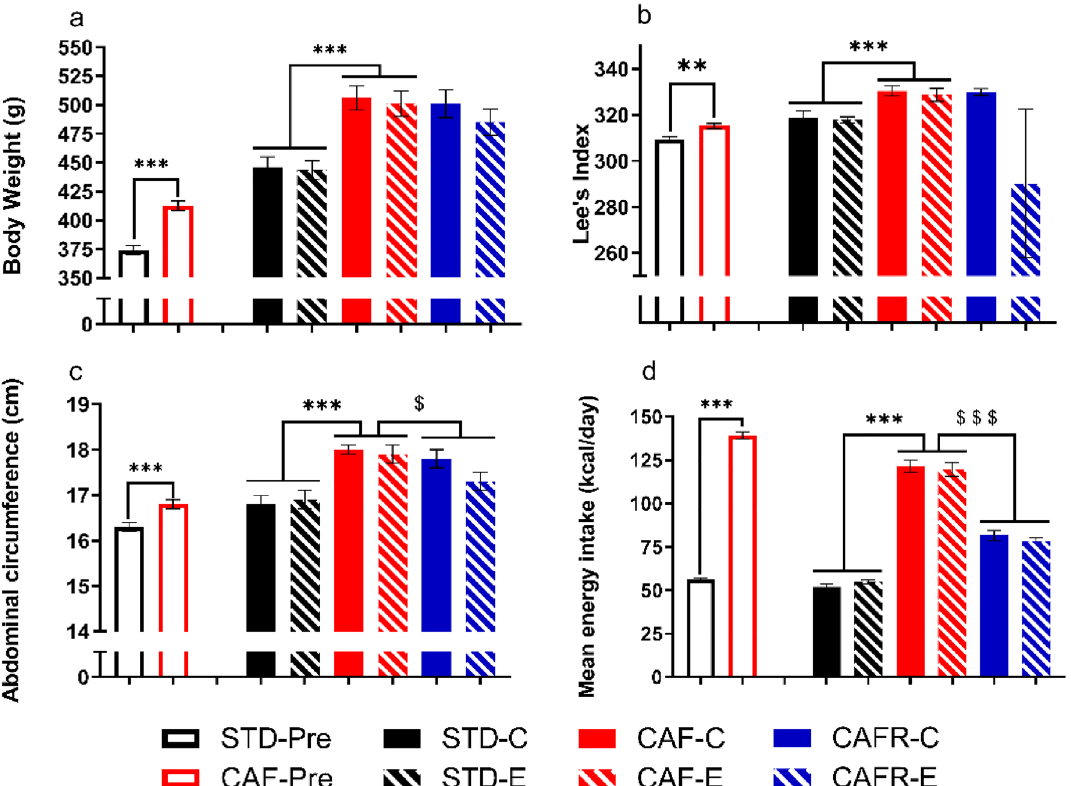
Figure 2. Effects of dietary interventions and exercise on biometric parameters and mean energy intake. ( a ) Body weight (g). ( b ) Lee Index. ( c ) Abdominal circumference (cm). ( d ) Mean energy intake (Kcal/day). Empty bars are data at the end of the obesity-induction period before the start of interventions (week 10); and solid and dashed bars are data from the time of behavioral testing (week 18). Values are mean ± SEM. ** p < 0.01, *** p < 0.001 versus STD; $ p < 0.05, $$$ p < 0.001 versus